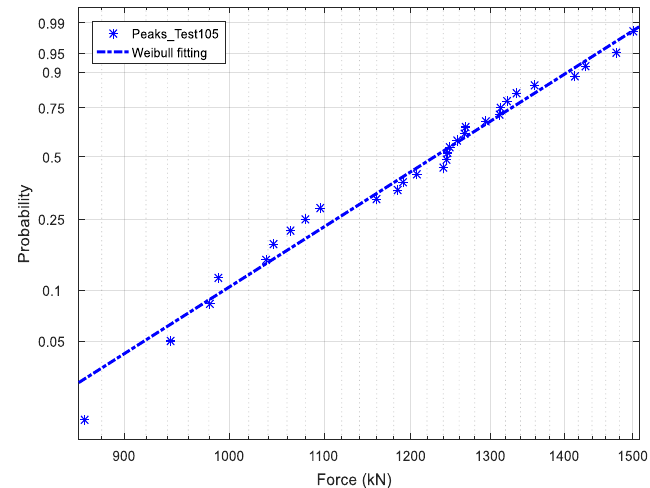
Figure 12. Weibull fitting of peaks of the ice force for test 105. Table 3. Statistics for the shape and scale factor of tests 105–108. Test No.